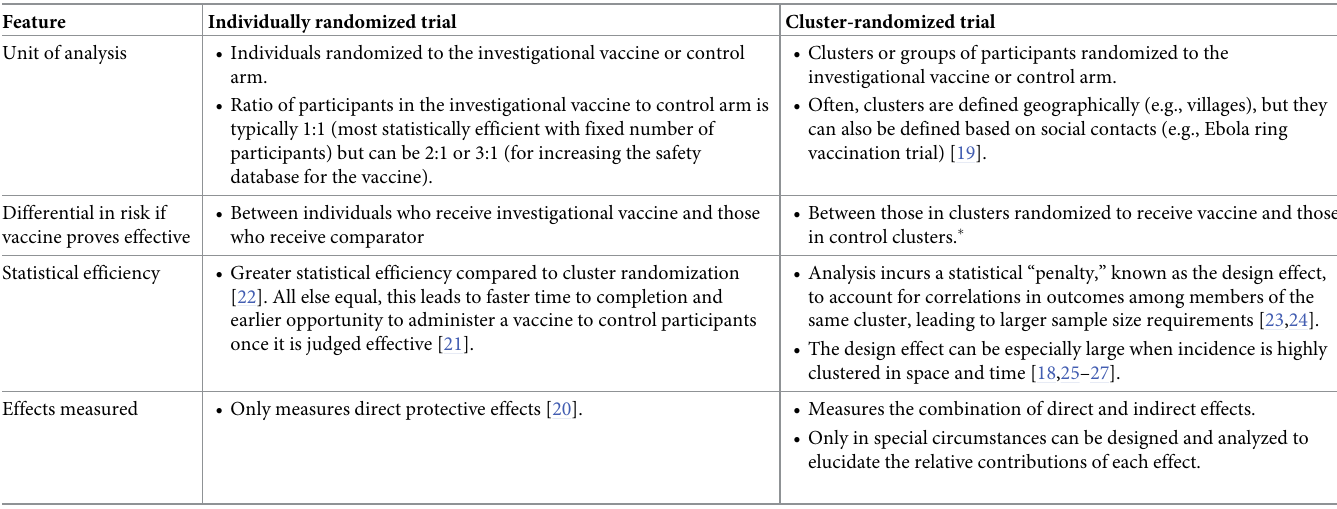
Table 2. Key features of individually randomized and cluster-randomized